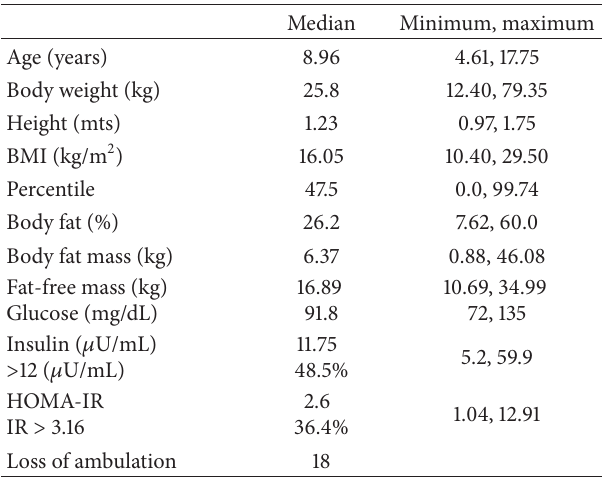
Table 1: Anthropometric and metabolic parameters in the study sample of DMD/BMD patients ( 𝑛 = 66).